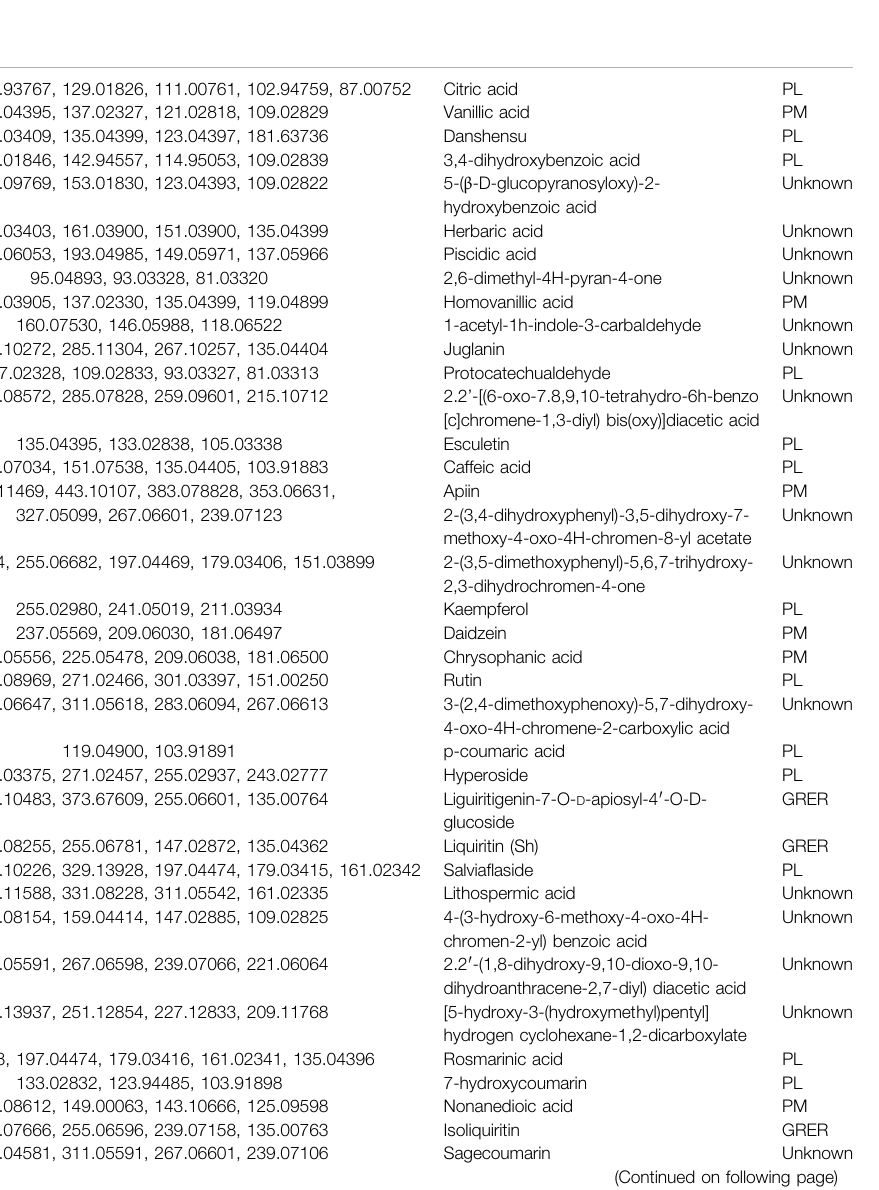
TABLE 2 | Main compound identi fi cation of Shuangxia decoction in the negative ion mode relies on the main visible chromatographic peak. Peak